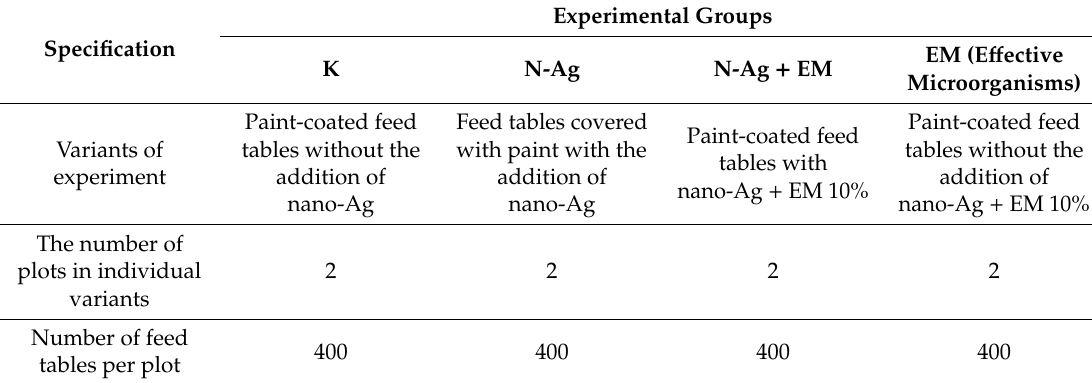
Table 1. Scheme of experimental